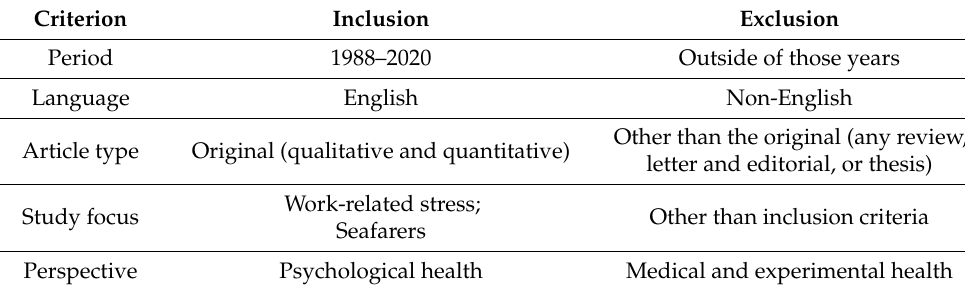
Table 2. Criteria for inclusion and exclusion of the